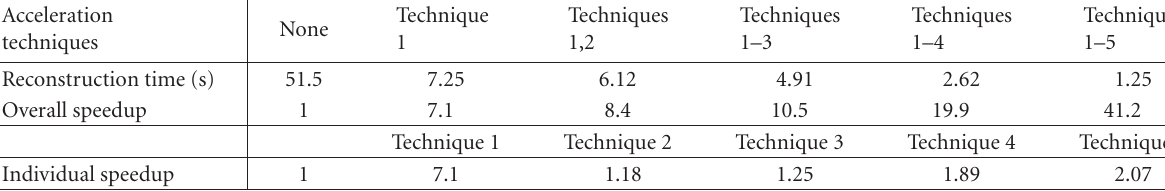
Table 2: Reconstruction results by applying techniques gradually.